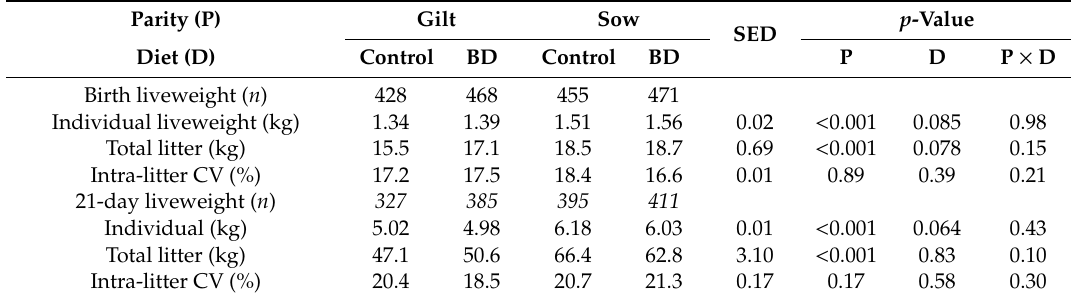
Table 3. Growth performance parameters of gilt and sow progeny fed a control or 1,3-Butanediol (BD) diet at 24 h and 21-days of age.